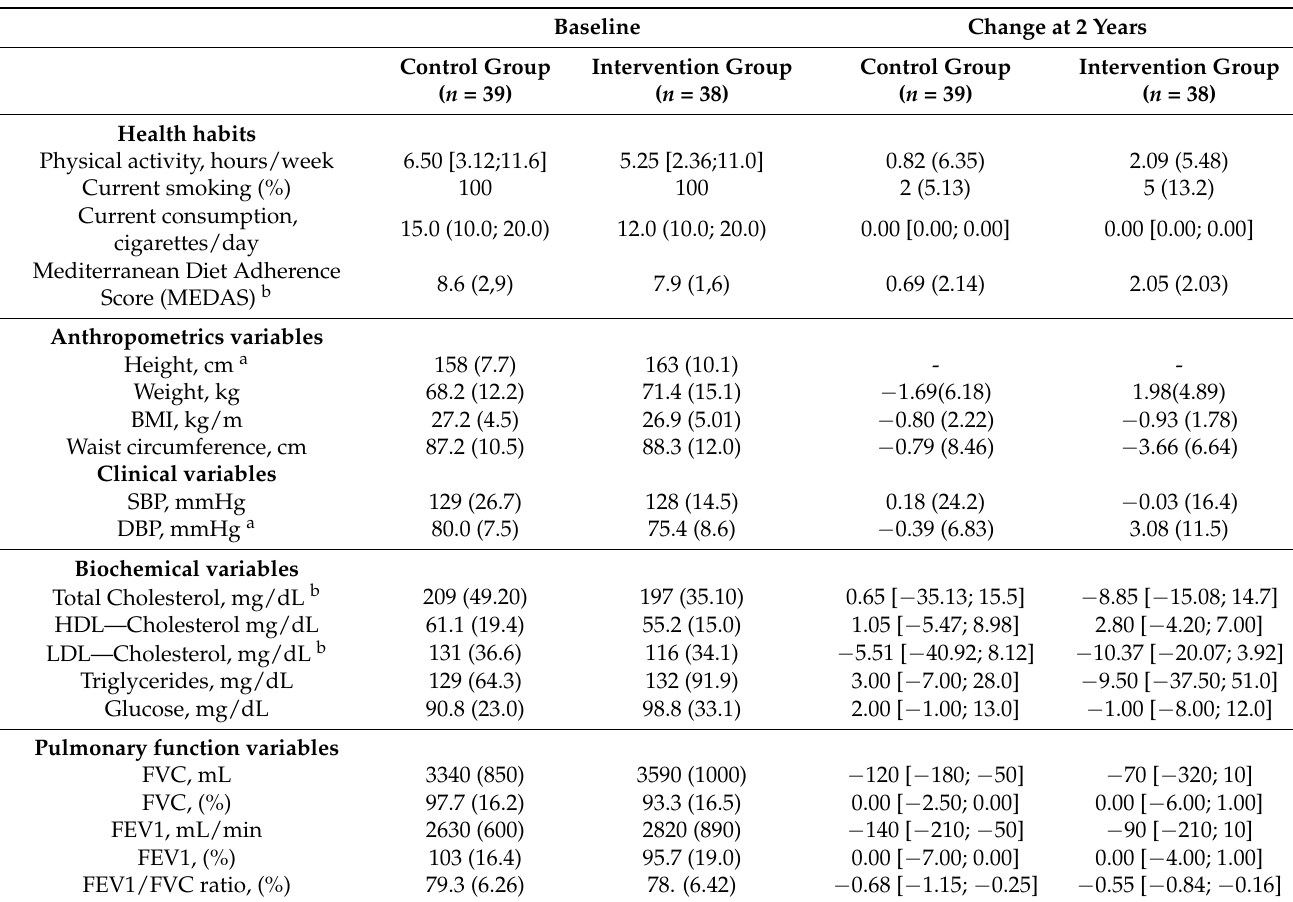
Table 1. Baseline and change at two-year follow-up characteristics of the study population, compared by